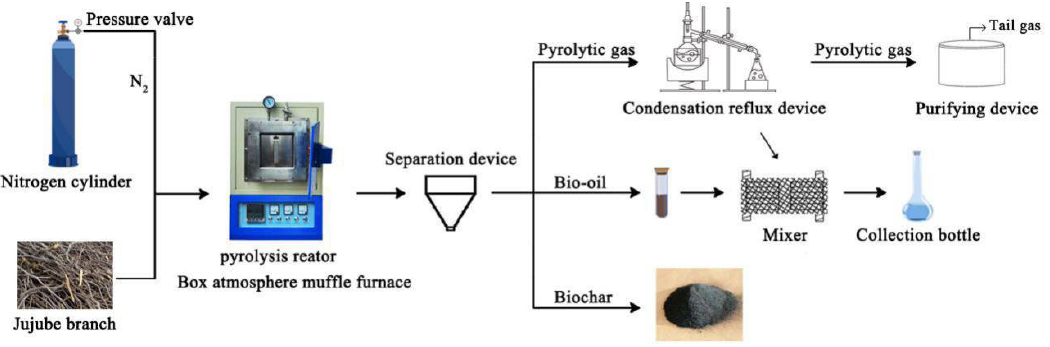
Figure 1. Schematic for carbonization process of jujube biomass.